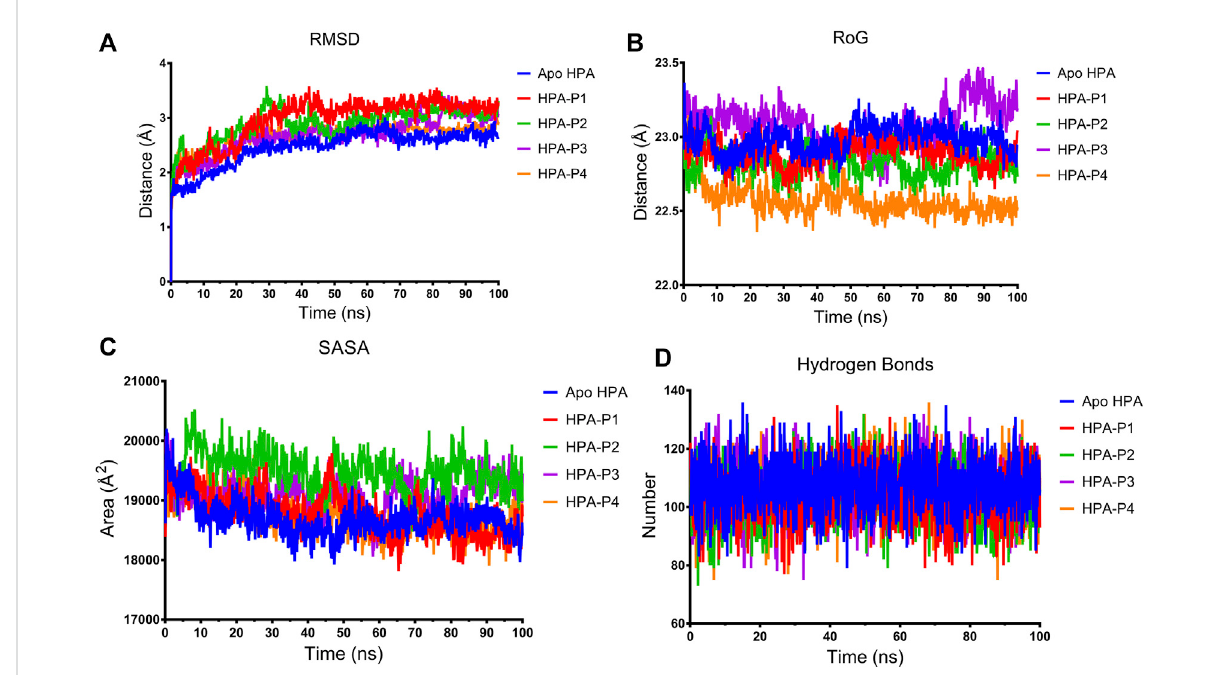
FIGURE 8 Structural stability of apo human pancreatic amylase and in complex with the isolated steroidal pregnanes. (A) Backbone root mean square deviation (RMSD) plots. (B) Radius of gyration (RoG) plots. (C) Surface accessible surface area (SASA) plots. (D) Change in the number of hydrogen bonds.